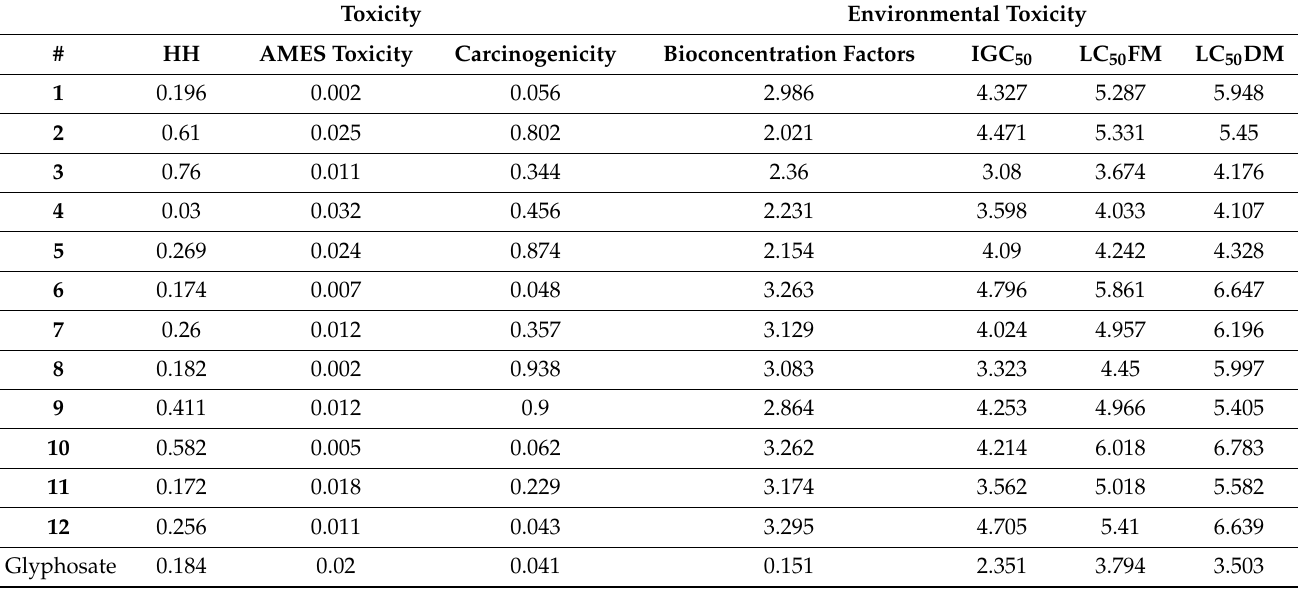
Table 6. In-silico analysis of toxicity of the volatile compounds of P. acutifolium and glyphosate. List of volatile compounds: 1. α -pinene; 2. β -myrcene; 3. α -phellandrene; 4. o-cymene; 5. β